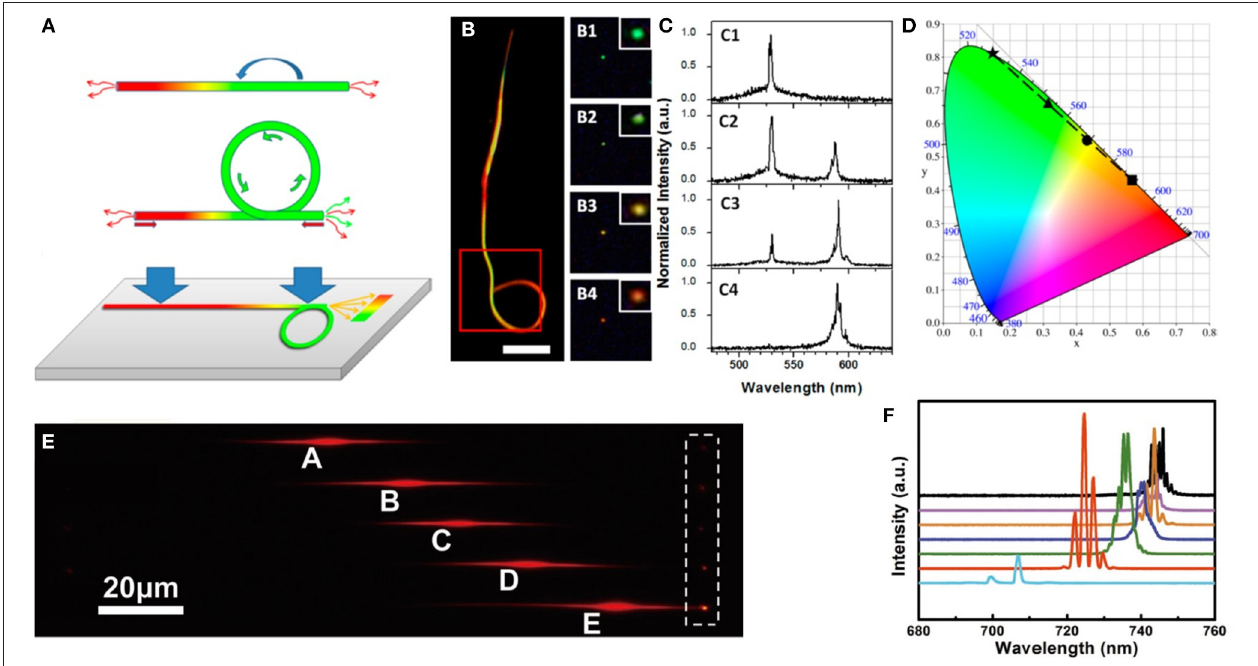
FIGURE 11 | (A) Up: Sketch of a straight CdSSe alloy nanowire. Middle: Sketch of the looped nanowire. Bottom: Design of the color-tunable laser using this looped nanowire by changing the relative strengths of pumping of the two segments. (B) Dark-field image of the looped nanowire, Scale bar: 10 µ m. (B1-B4) Real color images of the lasing under different pumping for the two cavities. (C) Normalized lasing spectra under different controlled pumping intensities. (D) The calculated colors from the spectra in C1-C4 plotted on CIE1931 color space. (E) PL microscope images of a single 150- µ m-long, 402-nm-diameter CdSe nanowire excited at different positions along its length. (F) Laser spectra with different nanowire lengths under the same pump beam size and intensity. Nanowire lengths for the spectra from left to right in the figure are 8, 20, 48, 102, 147, 179, and 289 µ m, respectively. (A–D) Reproduced with permission. Liu N. et al. (2013) Copyright 2013, American Chemical Society. (E,F) Reproduced with permission. Li Y. et al. (2013) Copyright 2013, Wiley-VCH.